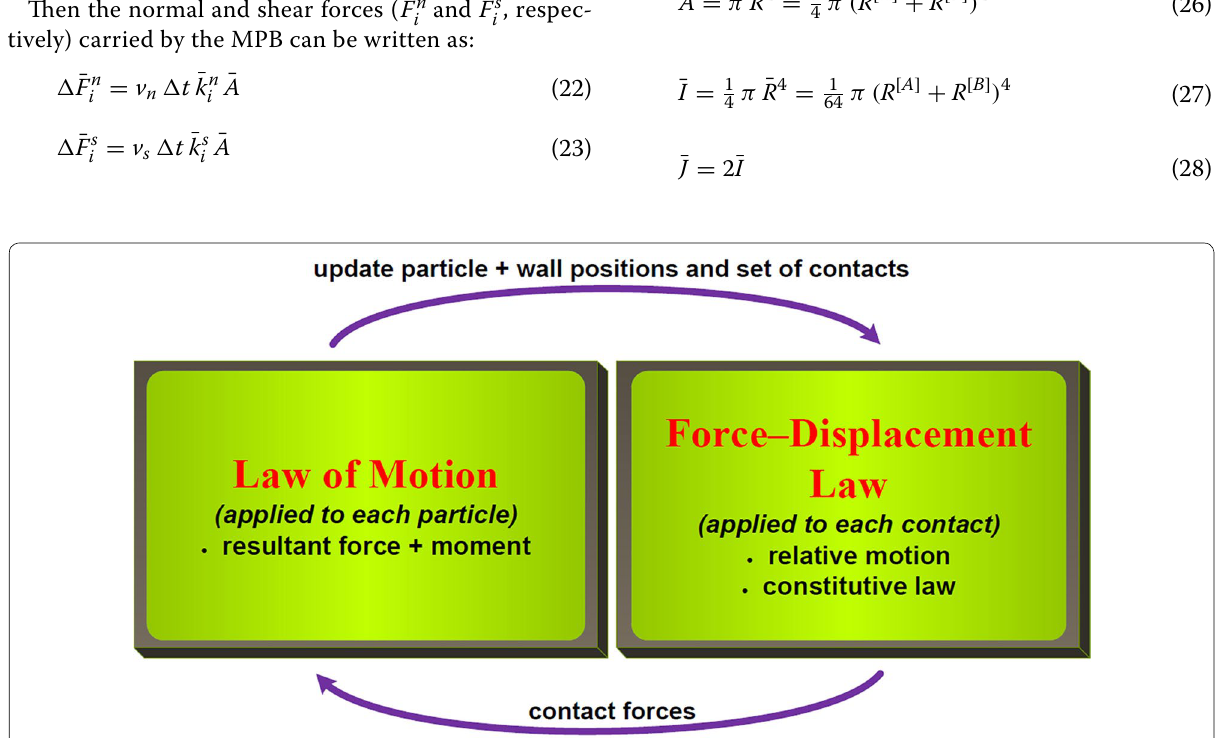
Fig. 7 Calculation cycle in PFC 3 D .